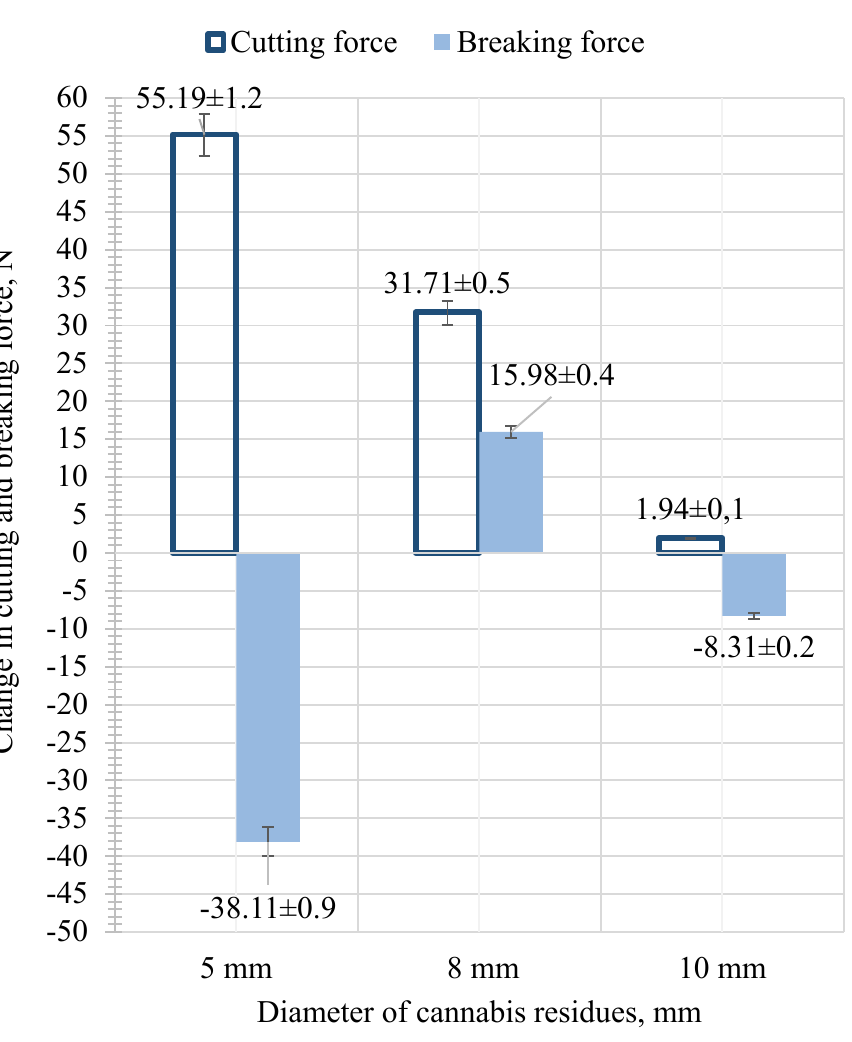
Figure 7. The effect of the shredding roller on the breaking force changes of cannabis residues (probability level p < 0.05).